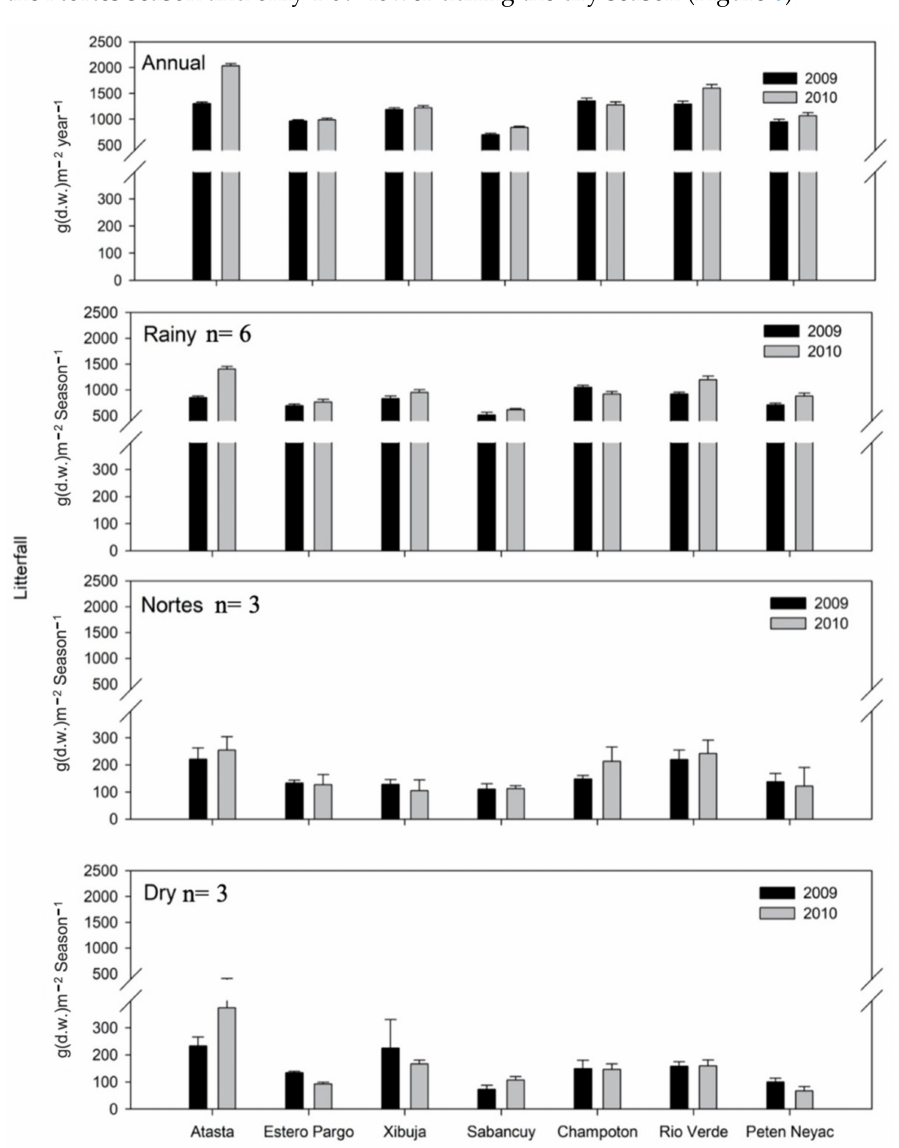
Figure 6. Litterfall ( ± SE = standard error) by year and season in seven mangrove forests along the coast of Campeche, Mexico for 2009 and